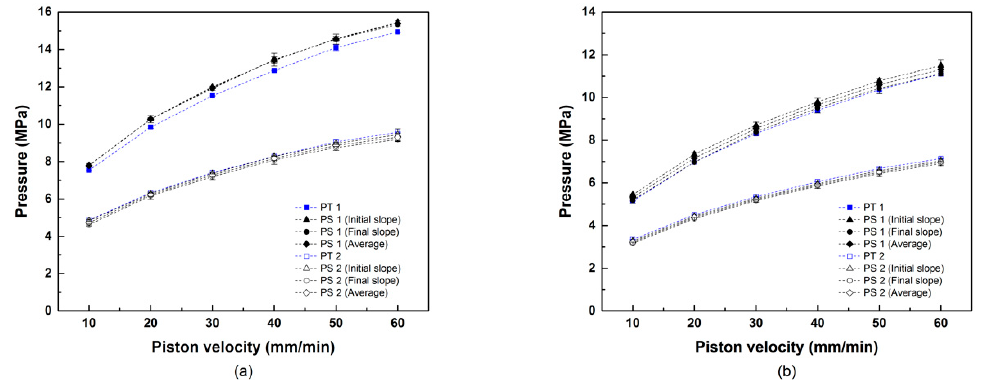
Figure 8. Comparison between the pressures obtained with the piezoelectric sensors and conventional transducers for each piston velocity. ( a ) LDPE at 150 °C. ( b ) LDPE at 180 °C. Initial slope and final slope refer to the values of s used in the fitting of V drift before actuating the piston or at the end of the ramp in piston’s velocity. Average indicates that drift correction is performed by computing the average of initial and final slopes s